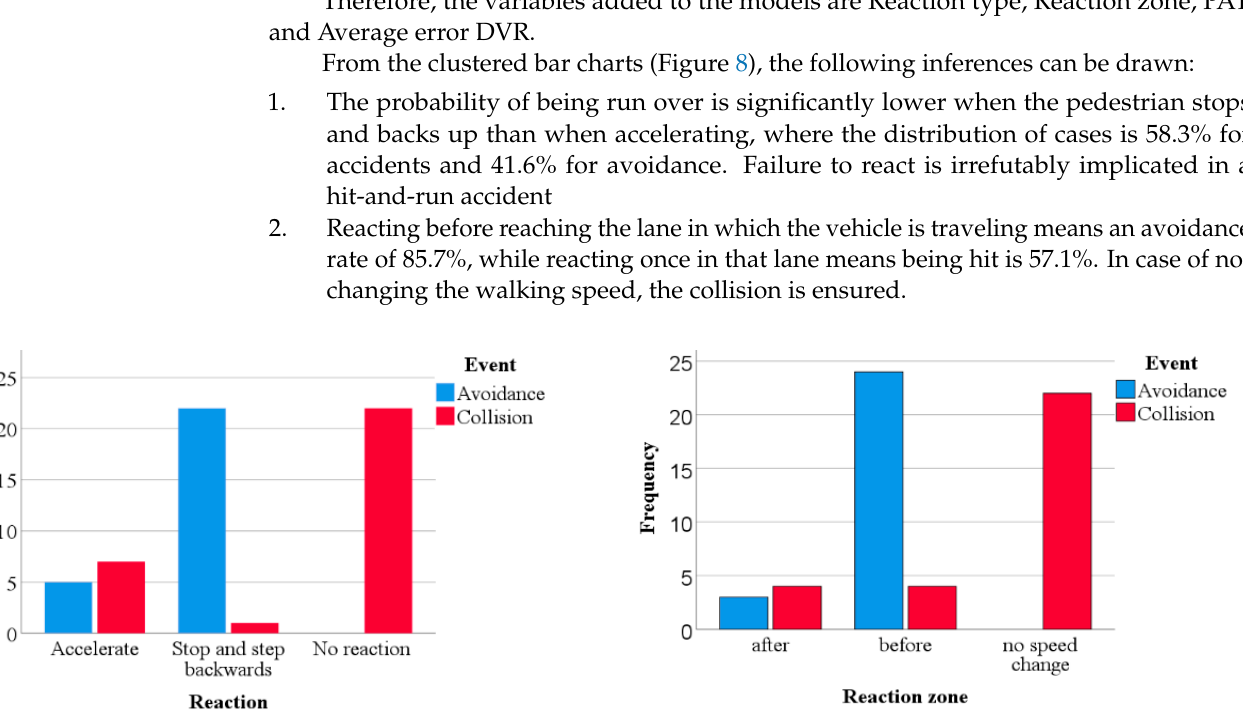
Figure 9. Boxplot chart of “Average error of distances calculated in VR” filtered by Event. In the scatter plot in Figure 10, notice how there is a great accumulation of avoidance cases for higher percentages of time with greater attention, while those who spend less time looking at an angle less than that defined as the limit tend to be hit. Some cases con- tradict this hypothesis, so they cannot be explained without the remaining estimators.